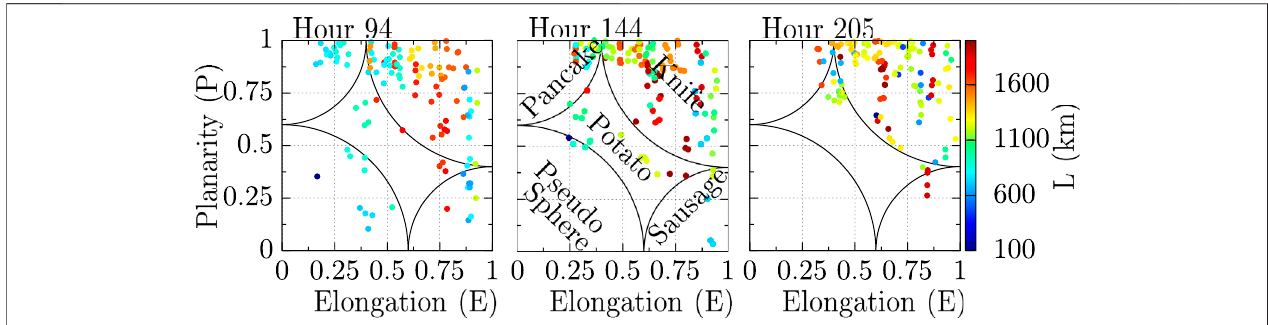
FIGURE 2 | Elongation and planarity of the 126 tetrahedron associated with the three nine-spacecraft con fi gurations under consideration, with characteristic lengths shown in color.